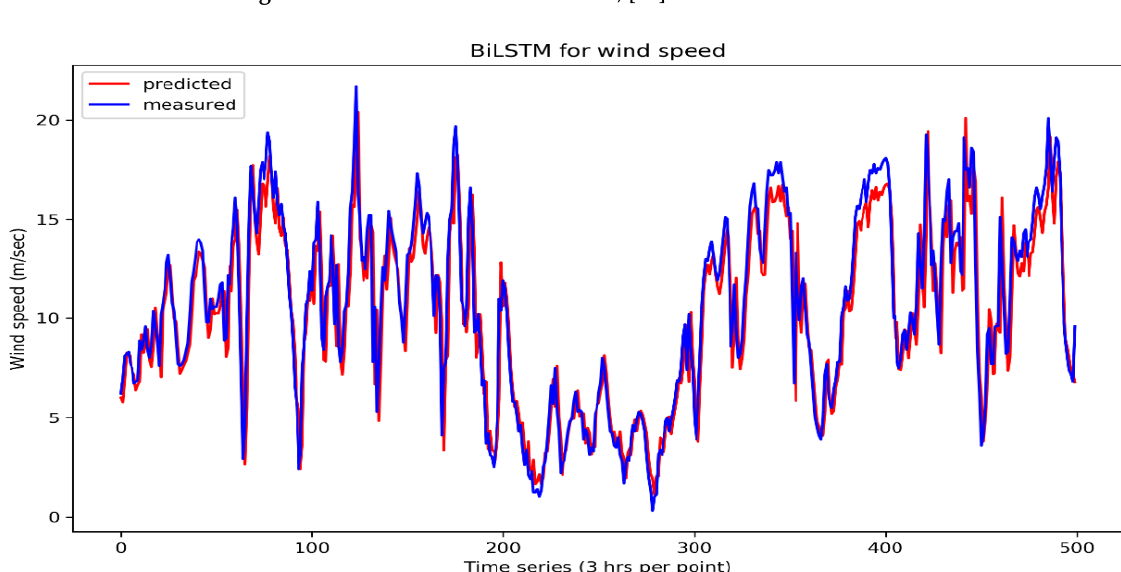
Energies 2022 , 15 , x FOR PEER REVIEW Figure 13. BiLSTM structure overview, [42]. Figure 13. BiLSTM structure overview, [42].